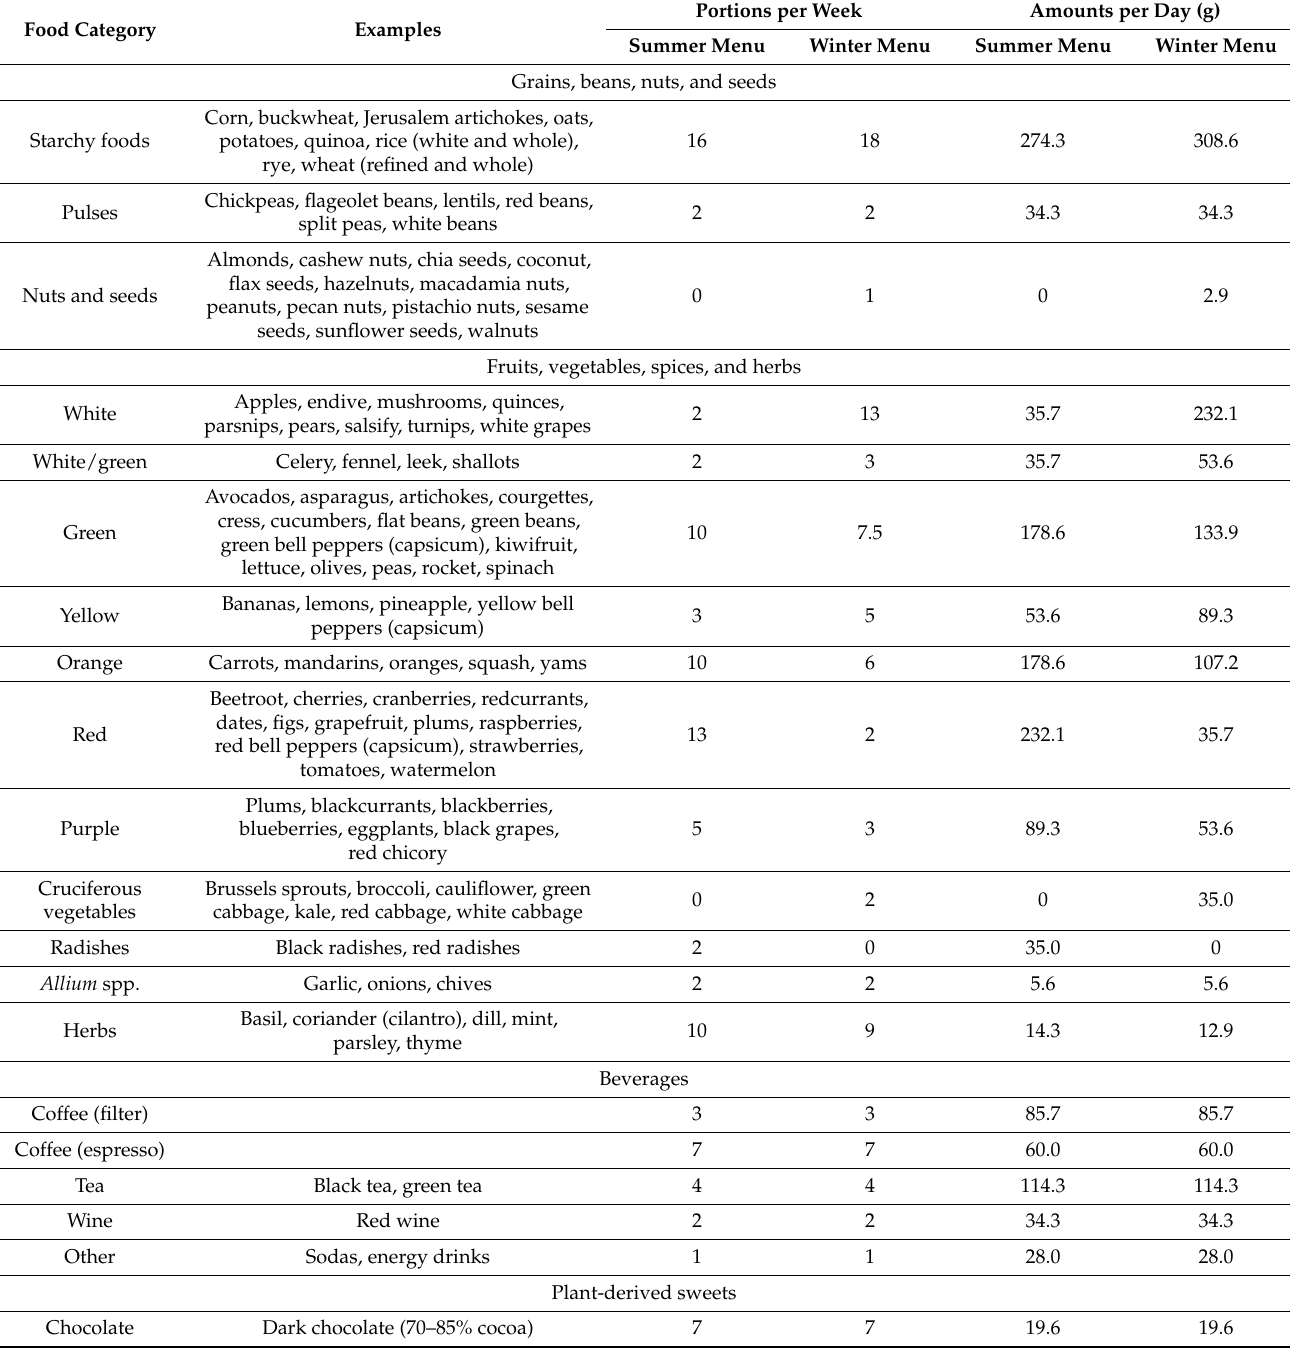
Table 2. Menu analysis, according to the number of portions of each food category consumed per week and the amount (expressed in grams) of each food category consumed per